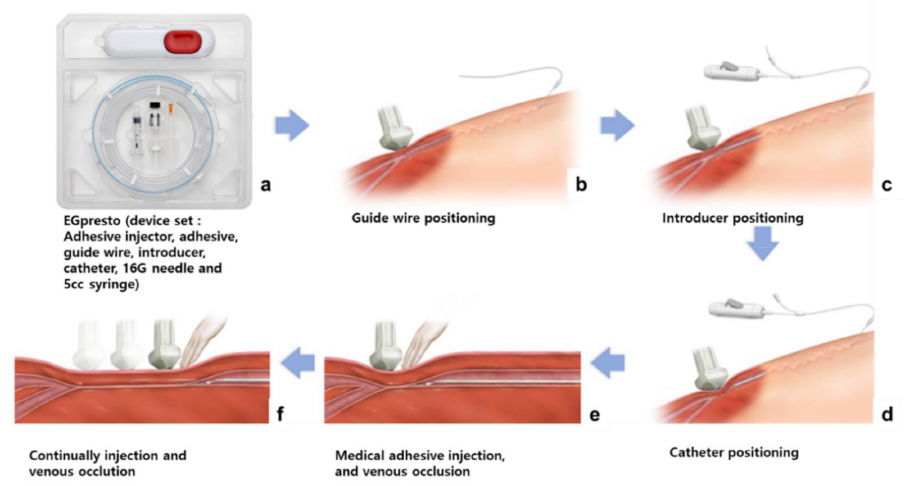
Figure 1. Schematic of the procedures for EGpresto™, a new venous occlusion system. ( a ) EGpresto comes in a plastic pouch containing a highly viscous glue in a vial, along with an injector, guide wire, introducer, catheter, 16 G needle, and a 5 cc syringe. ( b ) In the procedure, the guide wire is introduced through a small scission at the puncture site of the blood vessel. ( c ) The introducer is positioned. ( d ) The catheter is positioned at the location where the first glue will be discharged. ( e ) The adhesive is injected and pressed until the glue is cured. ( f ) After the catheter is pooled several cm back, the adhesive is injected again. The procedure is repeated until the venous occlusion is